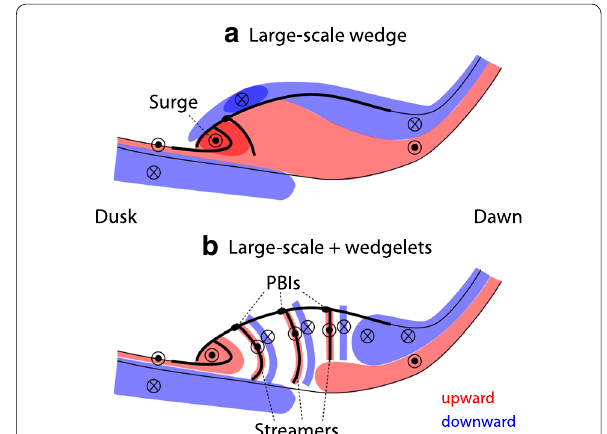
Fig. 6 Illustration of upward (red) and downward (blue) currents for events dominated by a the large-scale wedge and b a composite of the large-scale and wedgelet currents. The thin black lines mark the poleward and equatorward auroral boundaries. The thick lines mark bright auroral